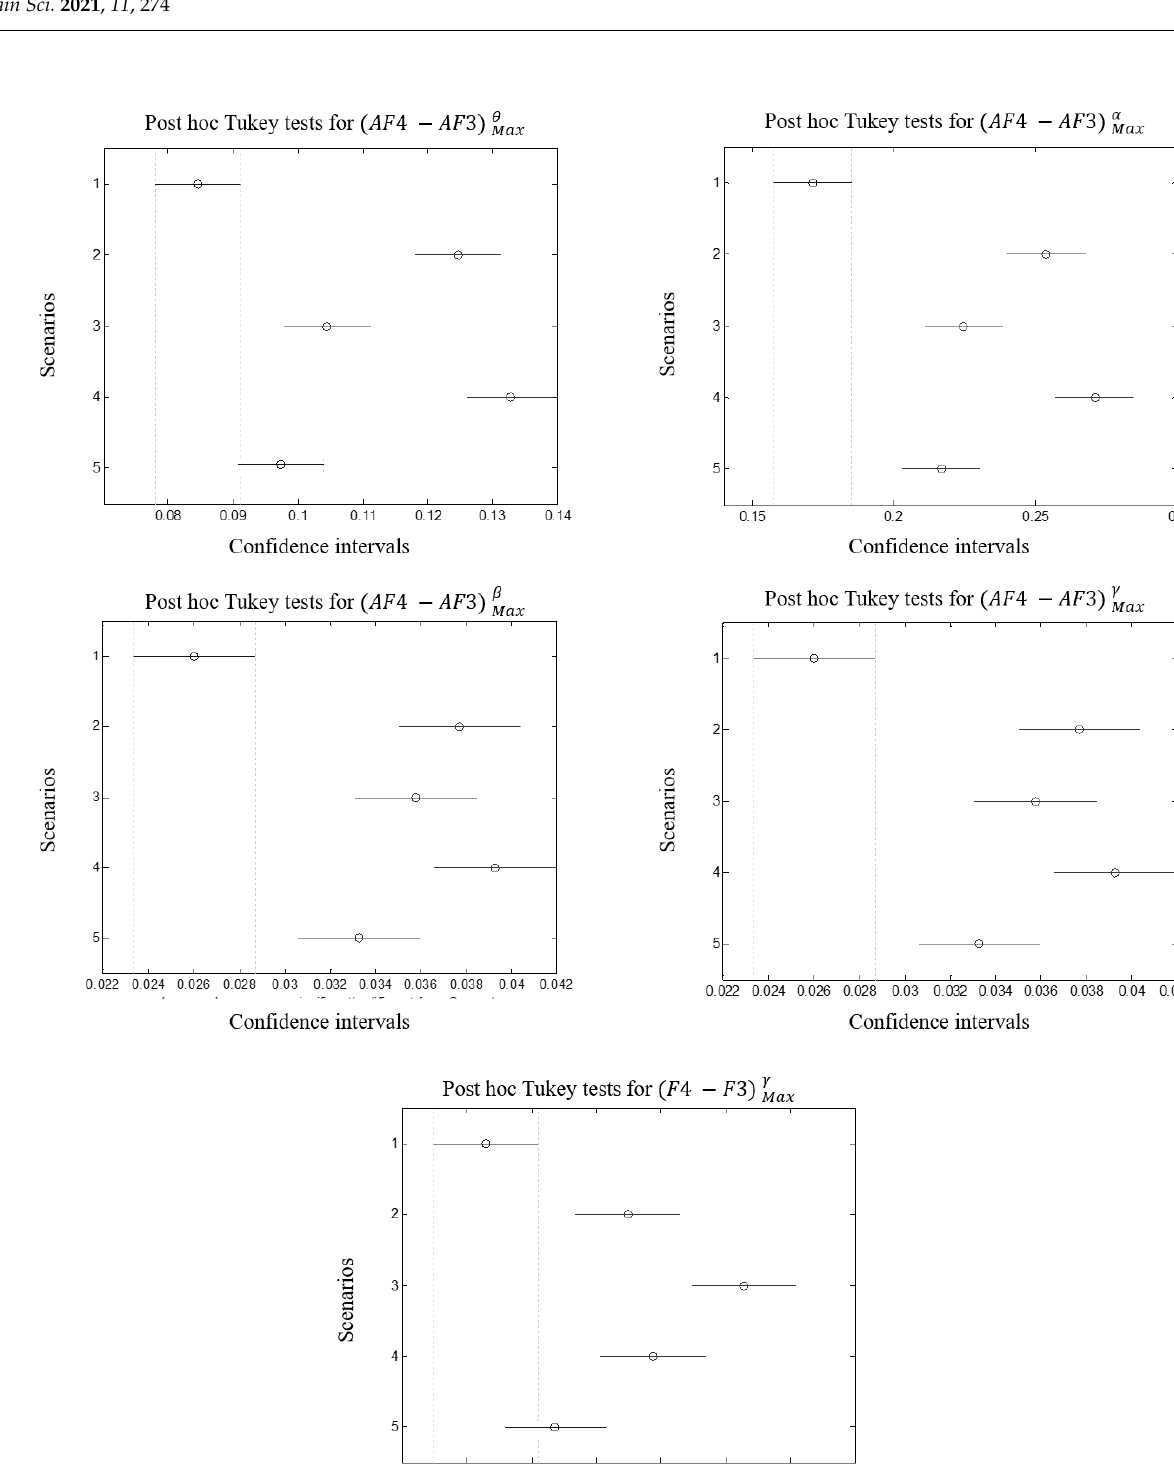
, P 7 δ , AF 4 θ , Max Max Max